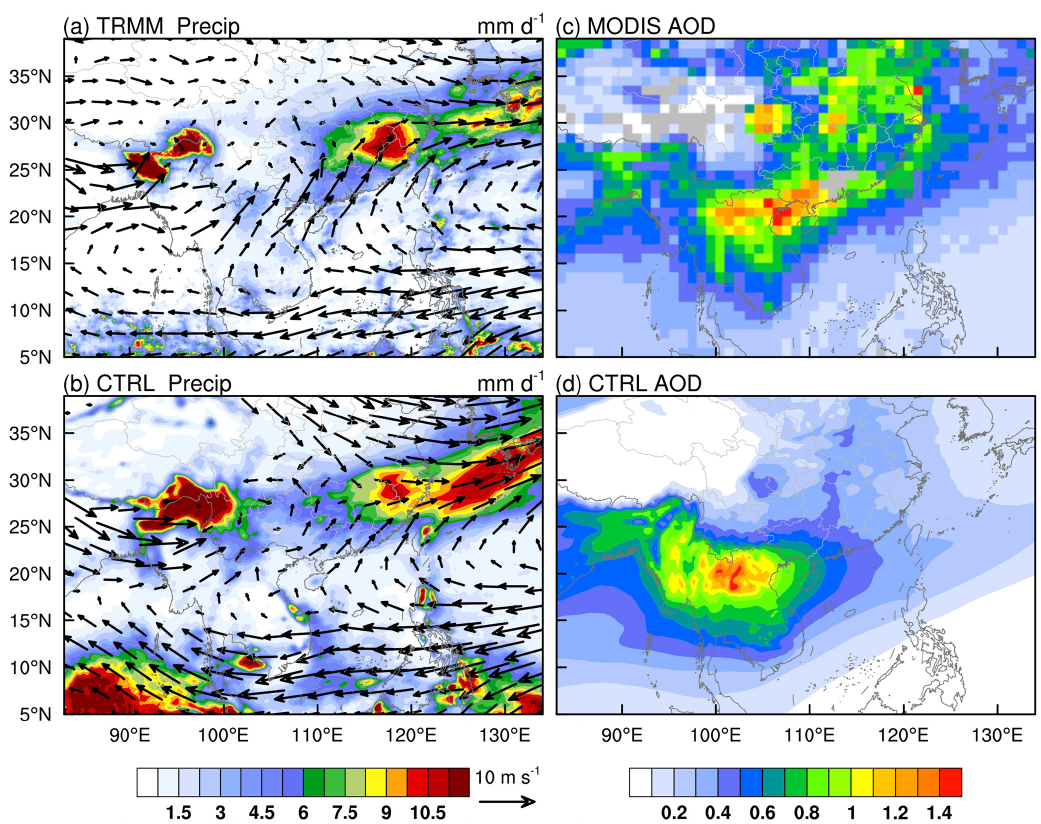
Figure 4. Spatial distributions of precipitation (shading; mmd − 1 ) and 850hPa wind (vector; ms − 1 ) averaged over the early spring (1 March to 20 April) of 2010 from (a) observations (TRMM precipitation and ERA5 wind) and (b) the ensemble mean of WRF-Chem CTRL. (c, d) Same as (a) and (b) but for AOD (shading; unitless) from (c) MODIS and (d) the ensemble mean of WRF-Chem